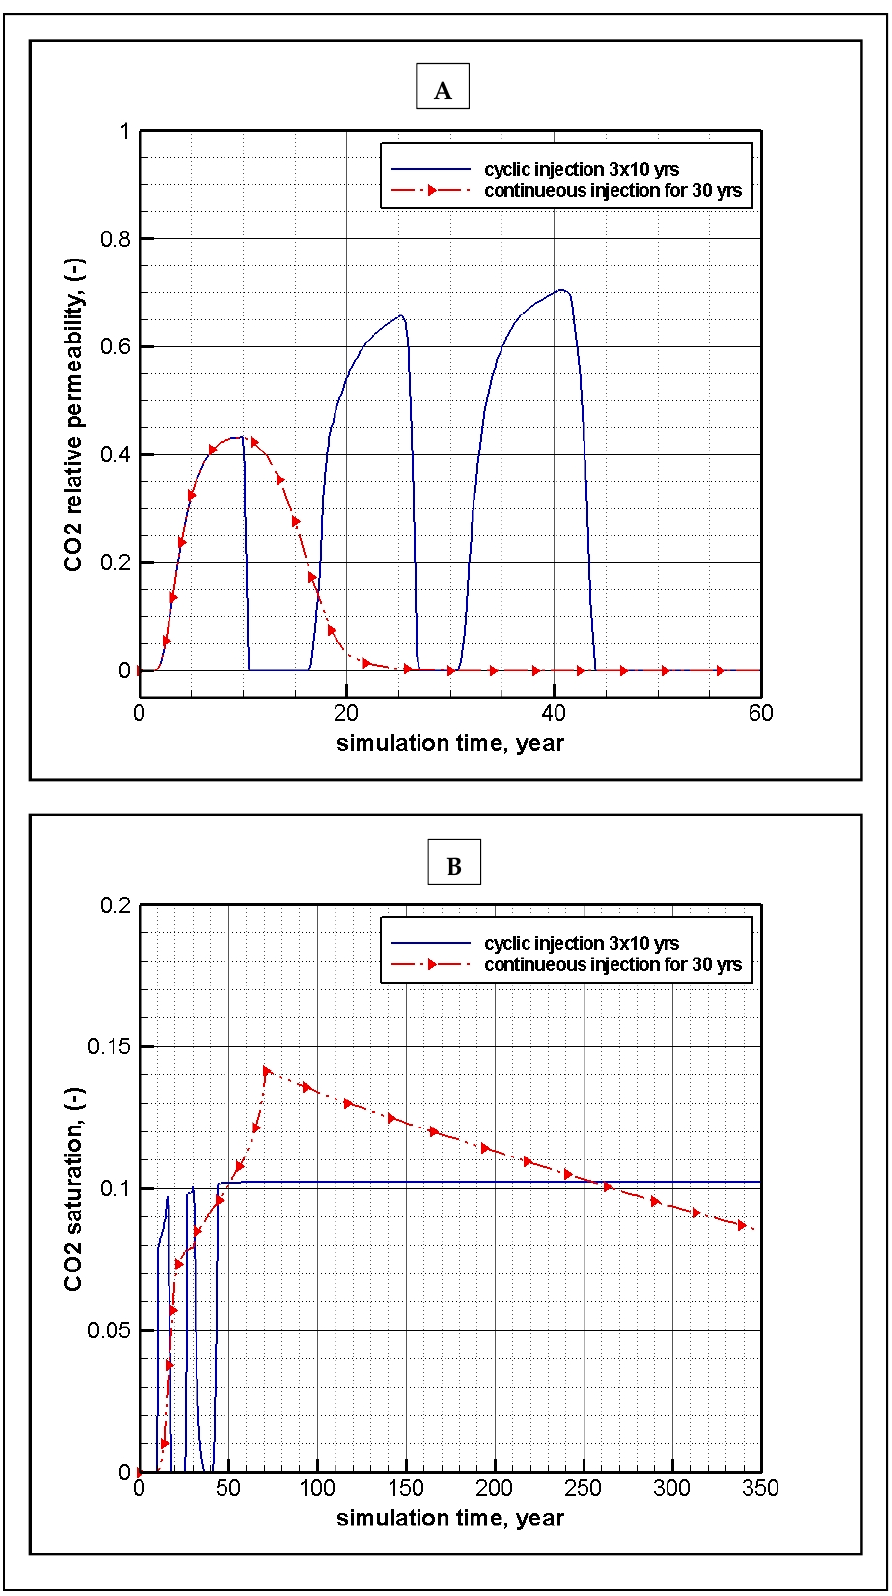
Figure 7. Impact of cyclic injection for cases 3 and 4 on: ( A ) CO 2 relative permeability; ( B ) CO 2 Figure7. Impactofcyclicinjectionforcases3and4on: ( A )CO 2 relativepermeability; ( B )CO 2 saturation.